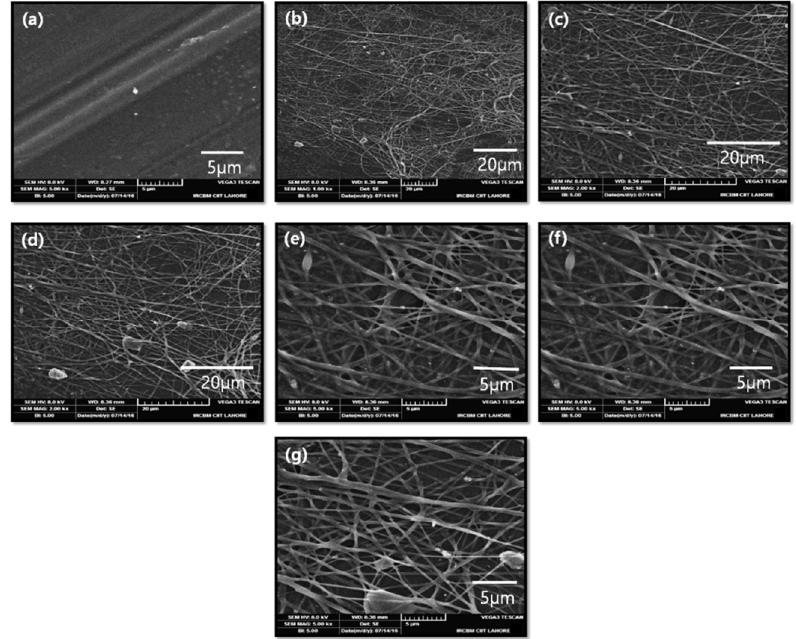
Figure 2. Scanning electron microscopy (SEM) micrographs of the ( a ) substrate, ( b ) control (CA), ( c ) CA-S1, ( d ) CA-S2, ( e ) CA-S3, ( f ) CA-S4, and ( g ) CA-S5 membranes. ( c ) CA-S1, ( d ) CA-S2, ( e ) CA-S3, ( f ) CA-S4, and ( g ) CA-S5